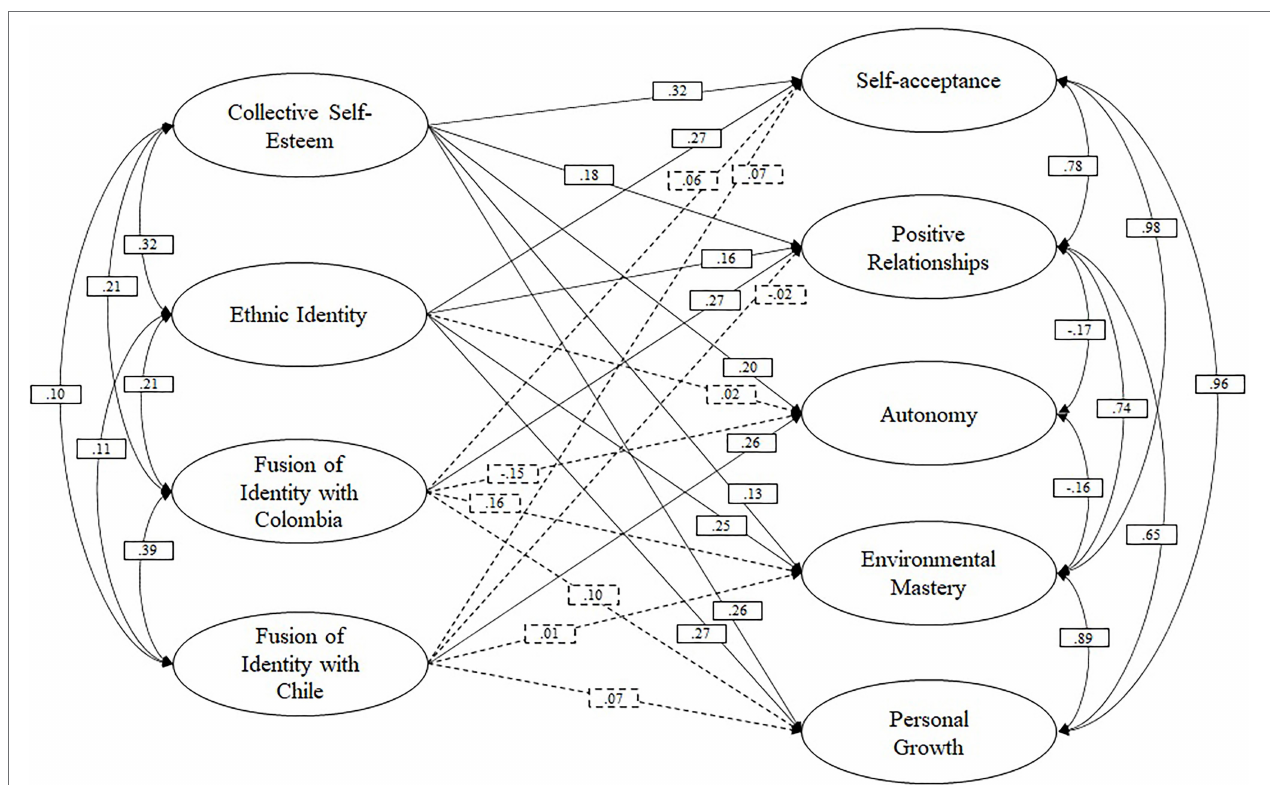
FIGURE 1 | Relationship between identity constructs and dimensions of psychological well-being. The analysis controlled for the effects of years spent in Chile and the degree of contact with other Colombians and Chileans. Solid paths indicate significant relationships ( p < 0.05). Non-significant paths are shown with dashed